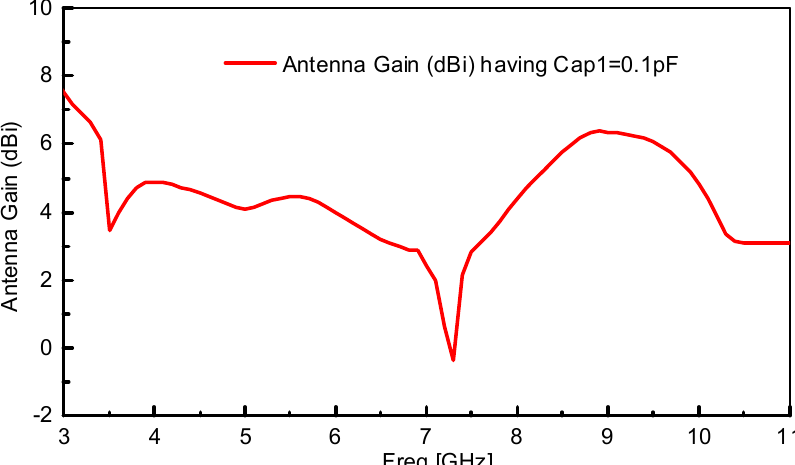
Figure 8. Simulated gain (dBi) of the proposed resonator based continuously tunable dual band-notched antenna at Cap1 = 0.1 pF.